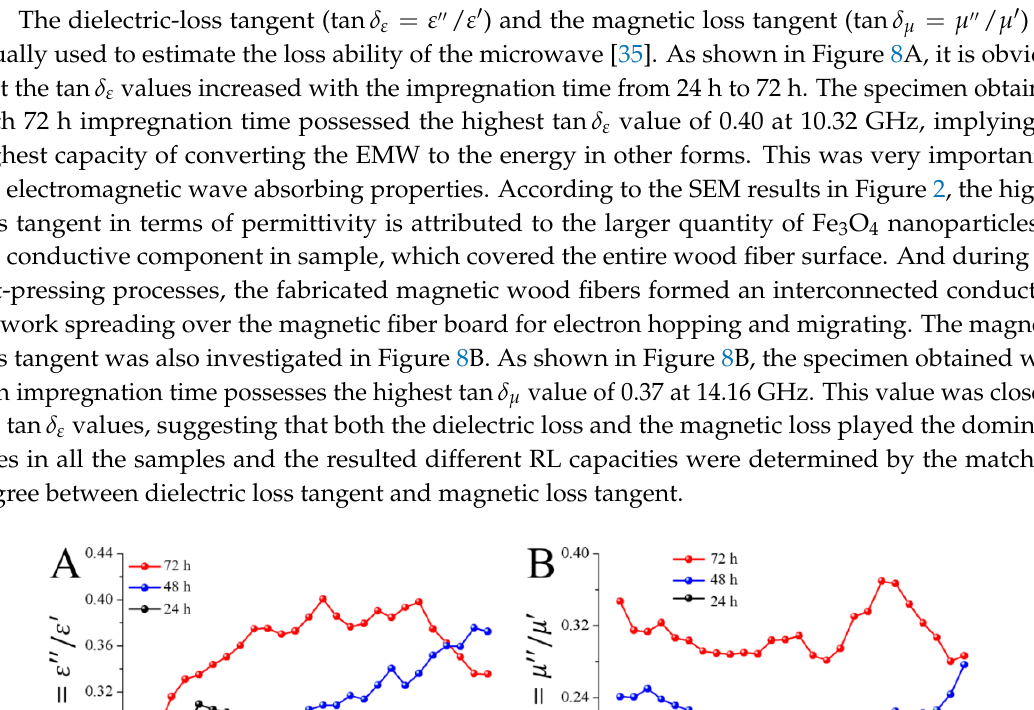
Figure 9. Scheme of primary EMI absorbing processes in the magnetic fiber board (Left): interfacial polarization (Right) at the interfaces between Fe 3 O 4 nanoparticles and the carbohydrates from the wood fiber surface, and conductive network (Middle) constructed by magnetic nanoparticles. The nanoparticles attached on the wood fiber surface and in the spaces among these fibers (as observed in Figure 3C) are labeled as black.